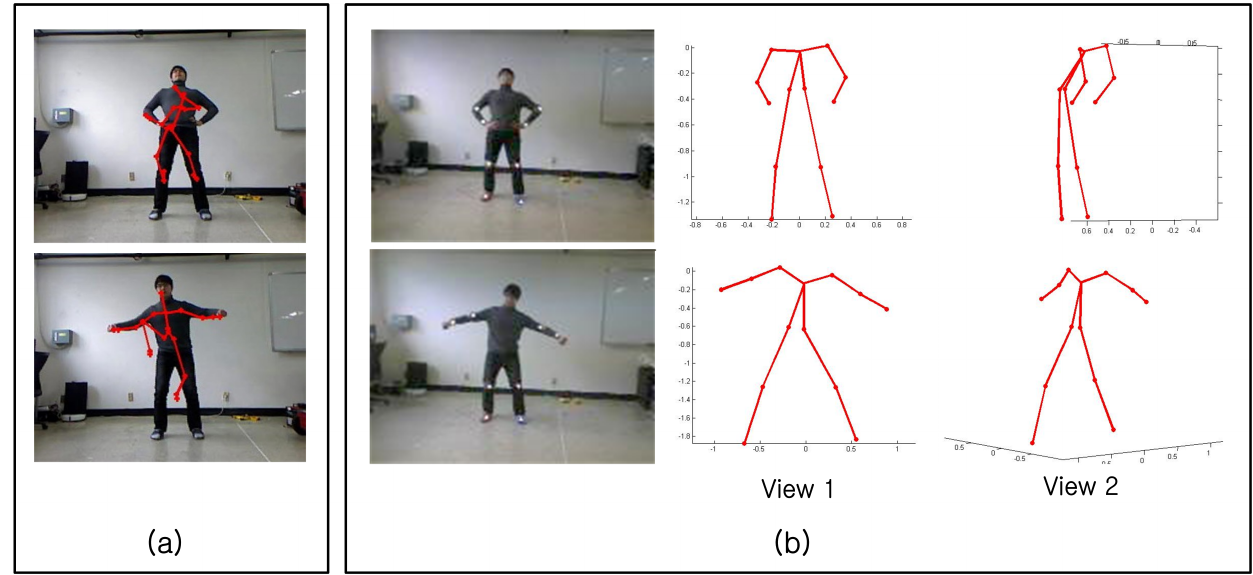
Figure 17. A comparison between Kinect and Samba under the bright lighting condition. ( a ) 3D pose reconstruction using Kinect. ( b ) 3D pose reconstruction using